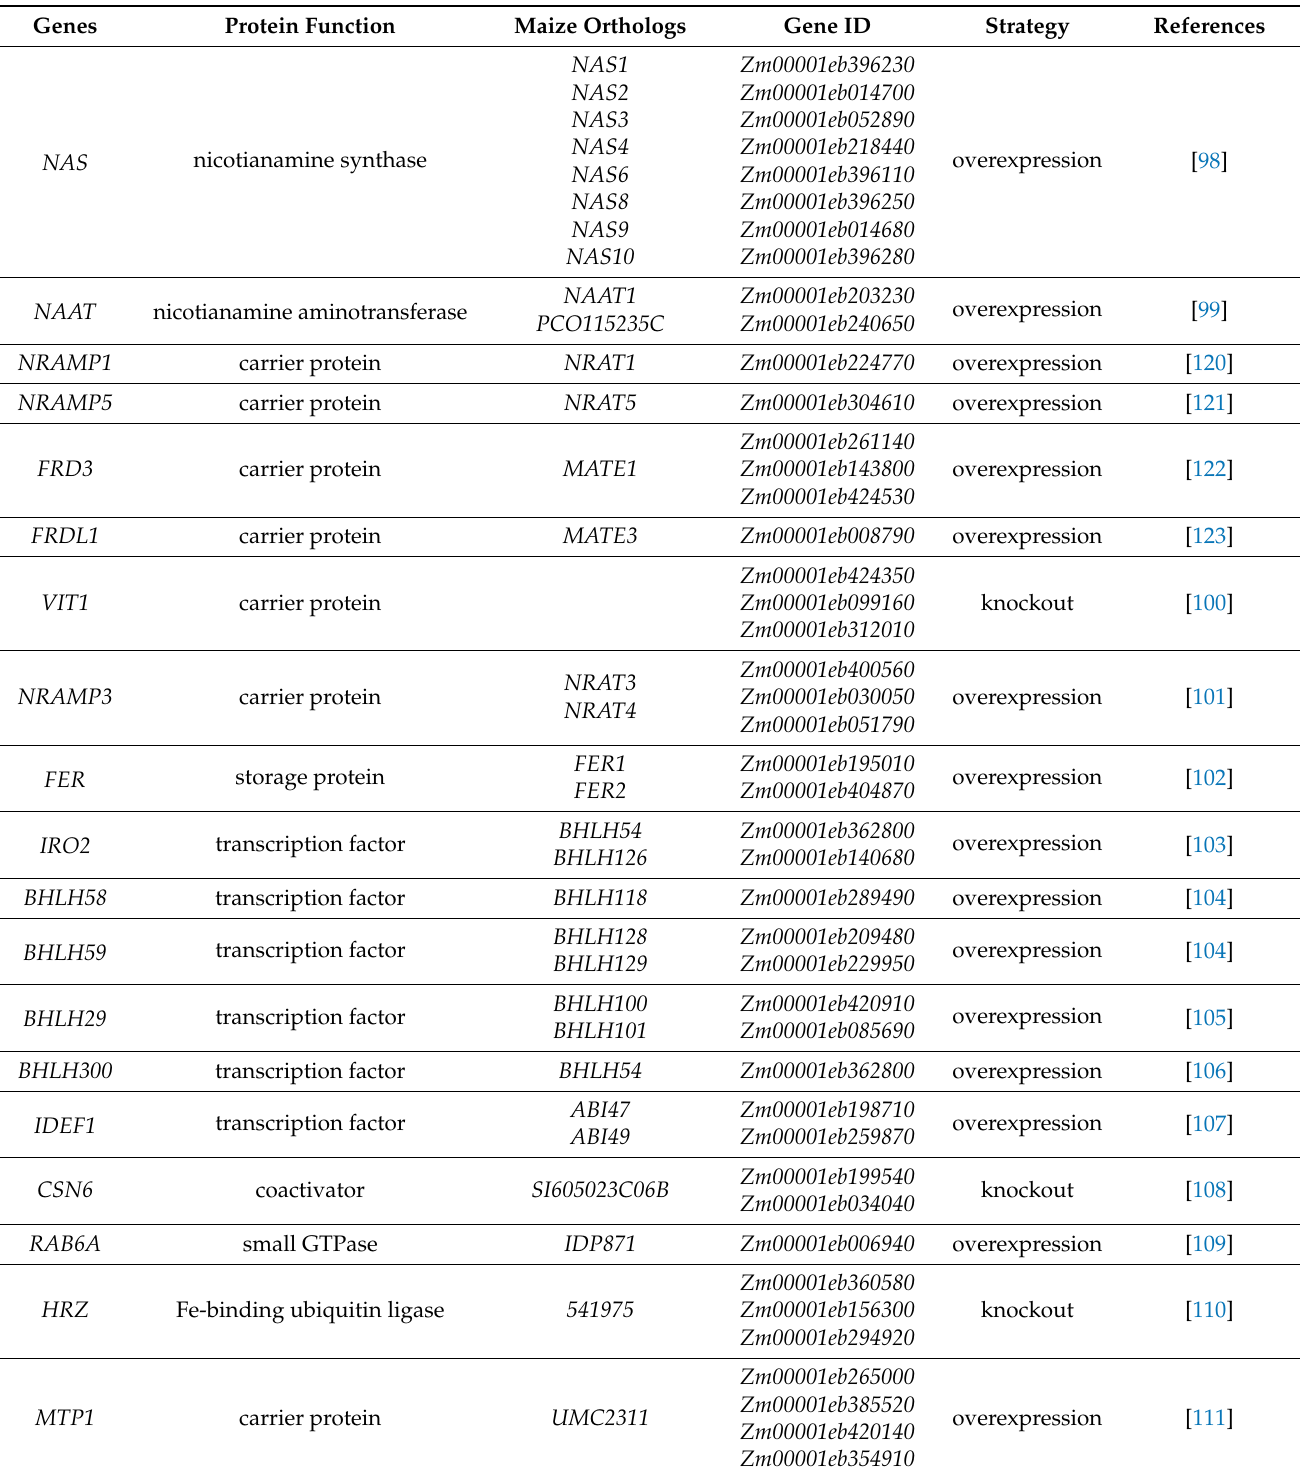
Table 5. List of potential gene resources for enhancing mineral contents in